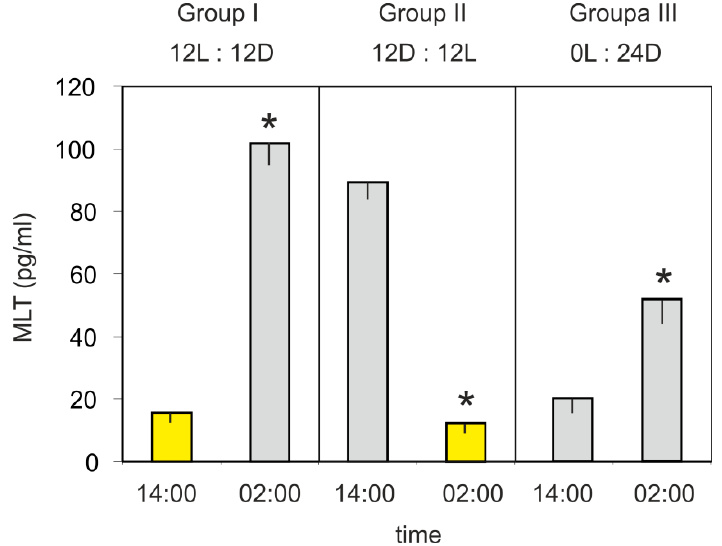
Figure 3. Experiment III. Concentration (mean and SEM) of melatonin in the blood plasma in 10-week-old turkeys kept under 12L:12D cycle (group I), 12D:12D cycle (group II), and continuous dim red light (group III) measured at 14:00 h and 02:00 h. Values significantly different between samples taken at 14:00 h and 02:00 h within each group were flagged with “*”.